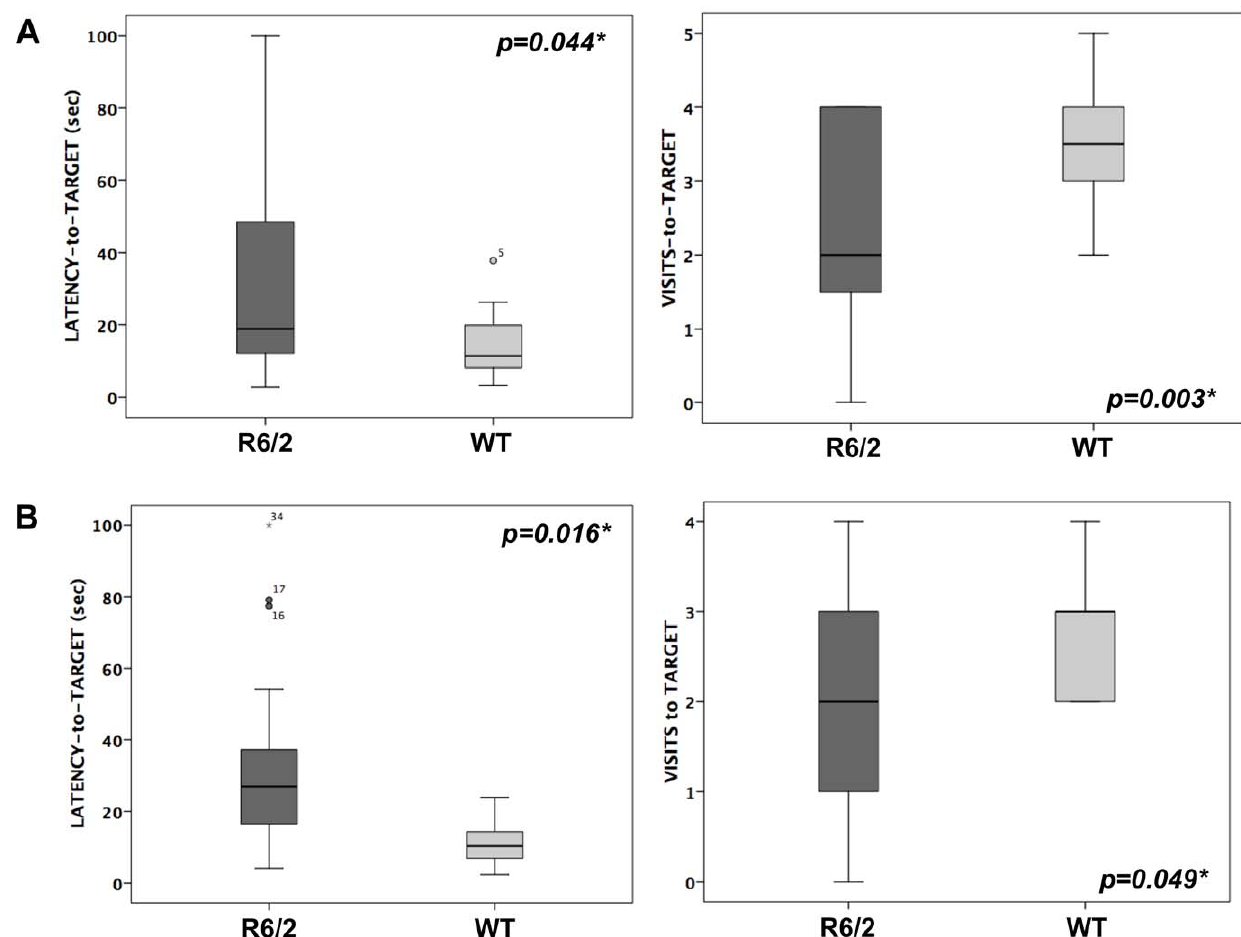
Figure 2. Barnes maze test in 6-week-old R6/2 and WT mice. Latency to reach the virtually target hole and numbers of pokes in the target hole were measured on day 5 (A) and day 12 (B). n=20 animals/group.